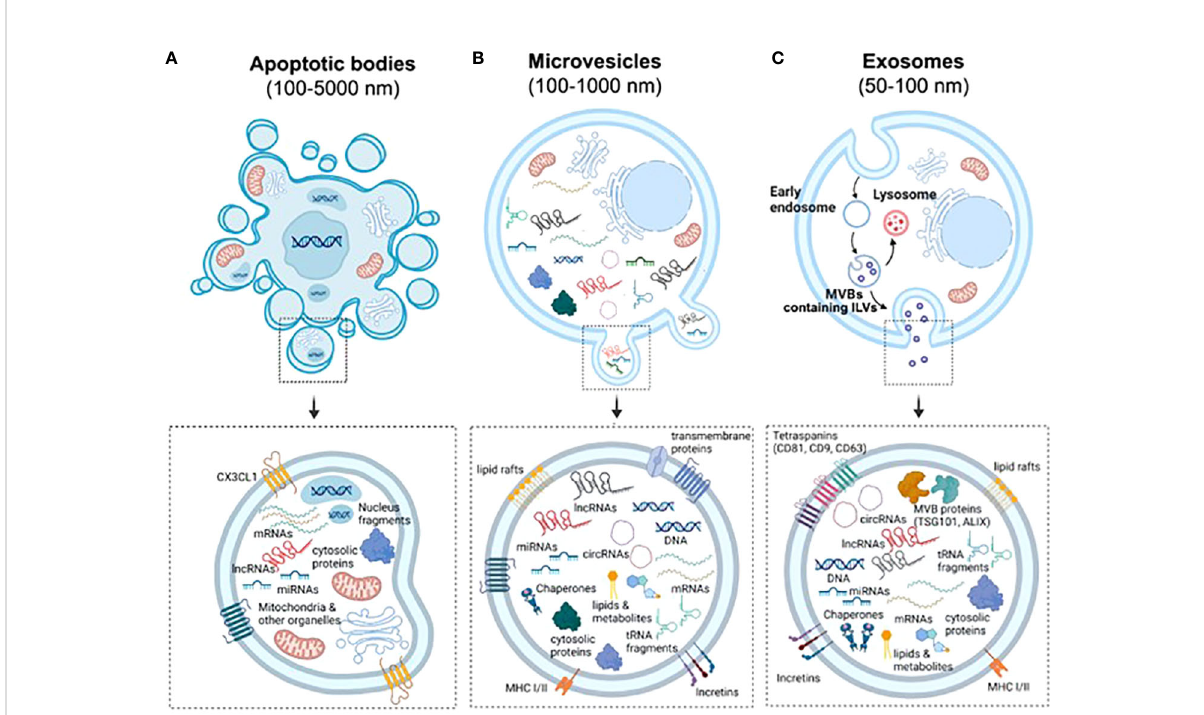
FIGURE 1 Biogenesis and characteristics of the three main types of EVs. (A) Apoptotic bodies are formed by blebbing of the plasma membrane during apoptosis. Similarly to other vesicles, they contain nucleic acids, proteins and different RNA species, but also fragments of the nuclei and full organelles such as mitochondria. (B) Microvesicles are formed by budding of the plasma membrane. Therefore, they contain the same transmembrane proteins, lipid rafts and domains than the surface of parental cells. Furthermore, the cargo of EVs include cytosolic proteins, lipids, metabolites, DNA, chaperones, mRNAs and ncRNAs (miRNAs, lncRNAs, cicRNAs and tRNA fragments, among others). (C) Exosomes are generated by the endosomal pathway in a process that involves the formation of endocytic vesicles by invagination of the plasma membrane, the inward budding of the endosomal membrane, followed by the formation of intralumenal vesicles and MVBs. Due to their biogenesis, exosomes can be distinguished by an enrichment of tetraspanins and the presence of proteins that form the endosomal sorting complexes required for transport (ESCRTs) required for the transport of